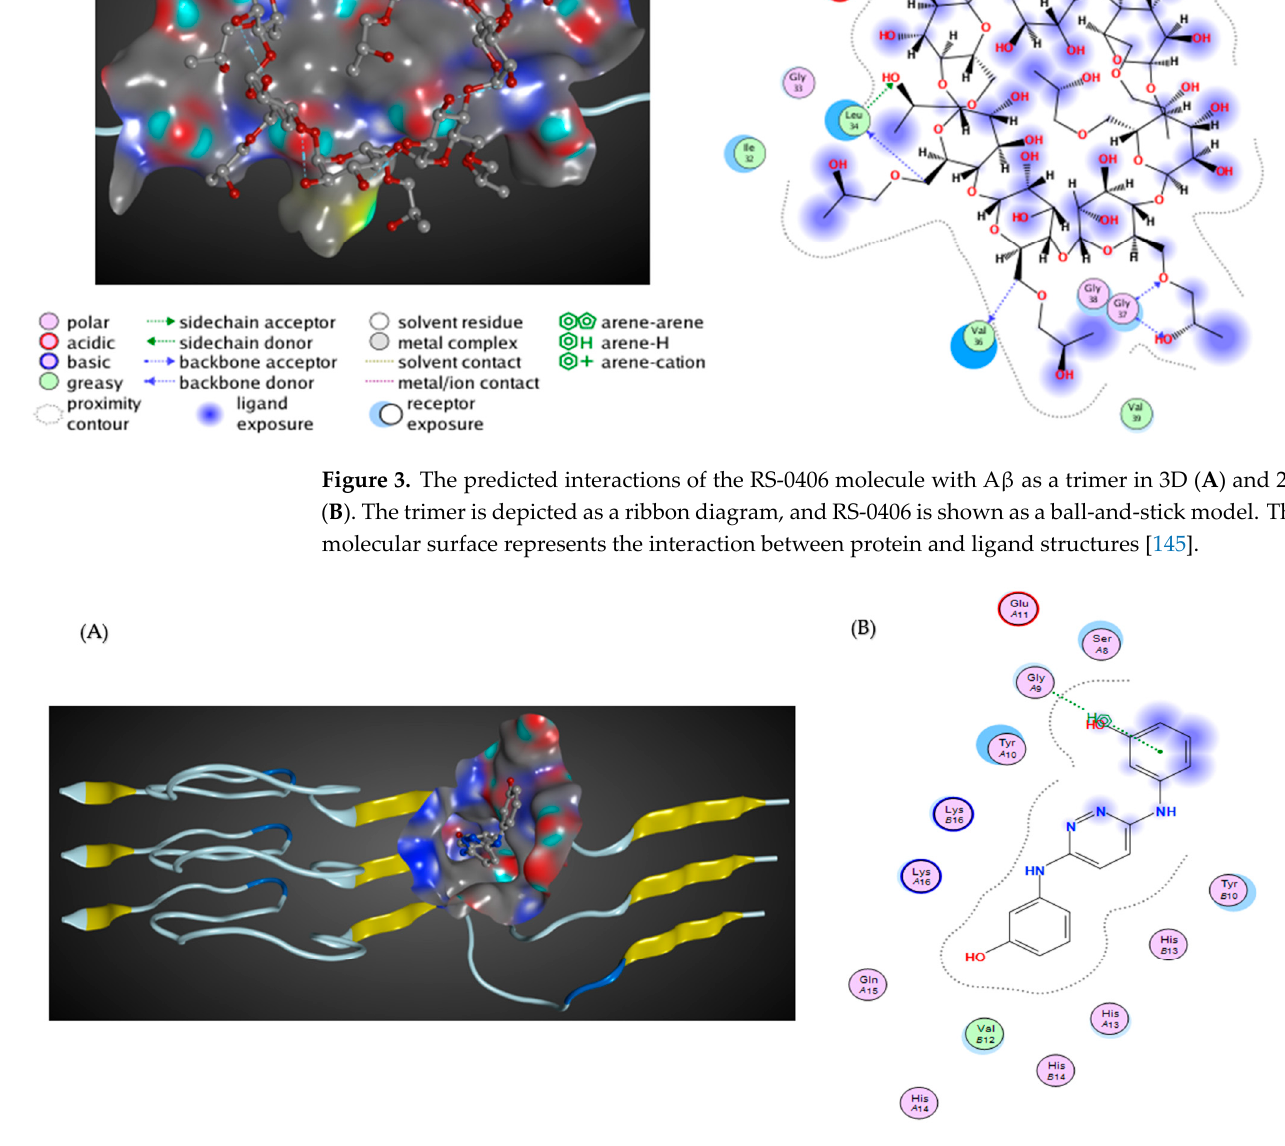
Figure 4. The predicted interactions of the HP β CD molecule with A β as a monomer in 3D ( A ) and 2D ( B ). The monomer is depicted in white color, and the cyclodextrin is shown as a ball‑and‑stick model. The molecular surface represents the interaction between protein and ligand structures. The predicted model was generated using the standard methodology (Lamarckian genetic algorithm), published elsewhere